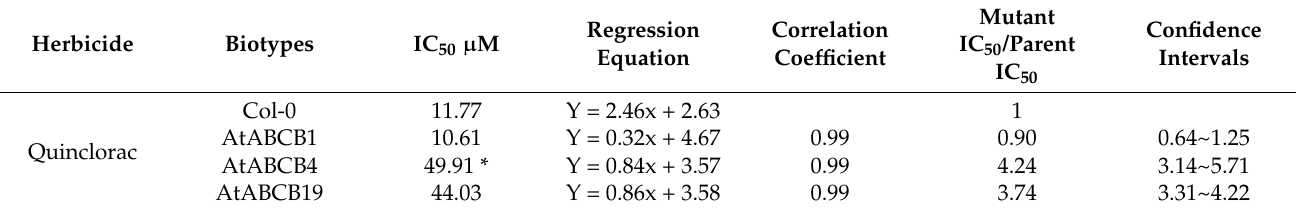
Table 4. The IC 50 were measured after treatment with quinclorac in the parent line and